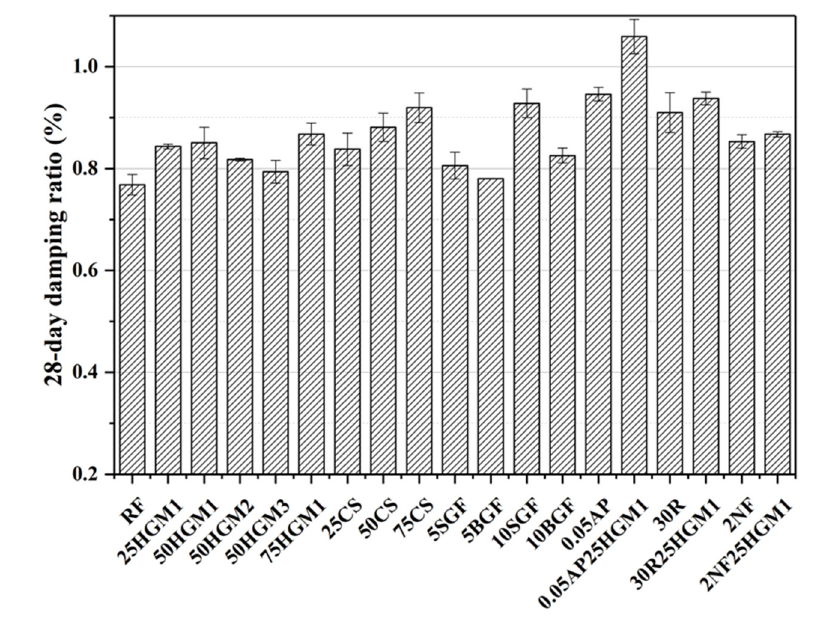
Figure 3. 28-day damping ratio of specimens.